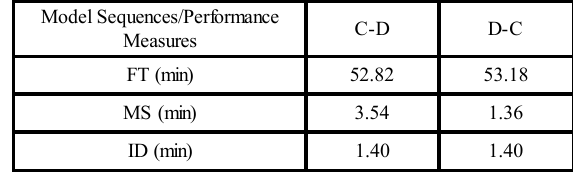
TABLE 3. NORMALIZED VALUE OF PERFORMANCE MEASURES